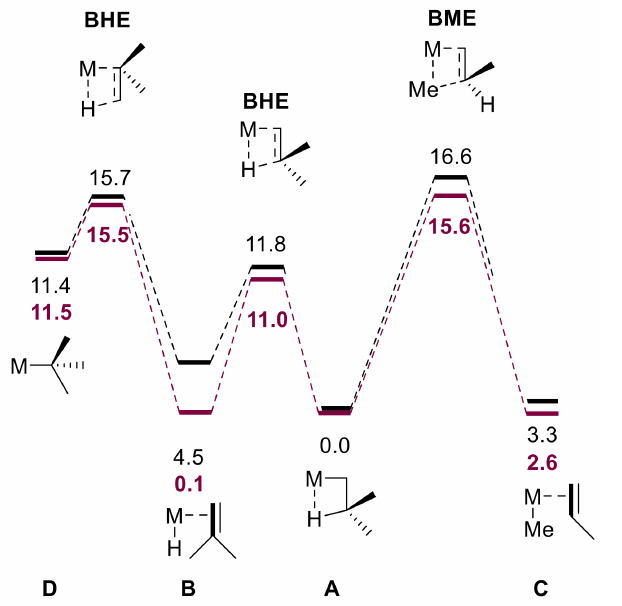
Figure 5. Potential energy surface for BHE and BME events in the M-2 catalyst pair (ligands omitted). Level of theory MN15(SMD)/cc-pVTZ-(PP)//MN15/cc-pVDZ-(PP), T = 100 ◦ C, Gibbs free energies in kcal/mol. Black traces and numbers for Zr-2 , burgundy traces and numbers for Hf-2